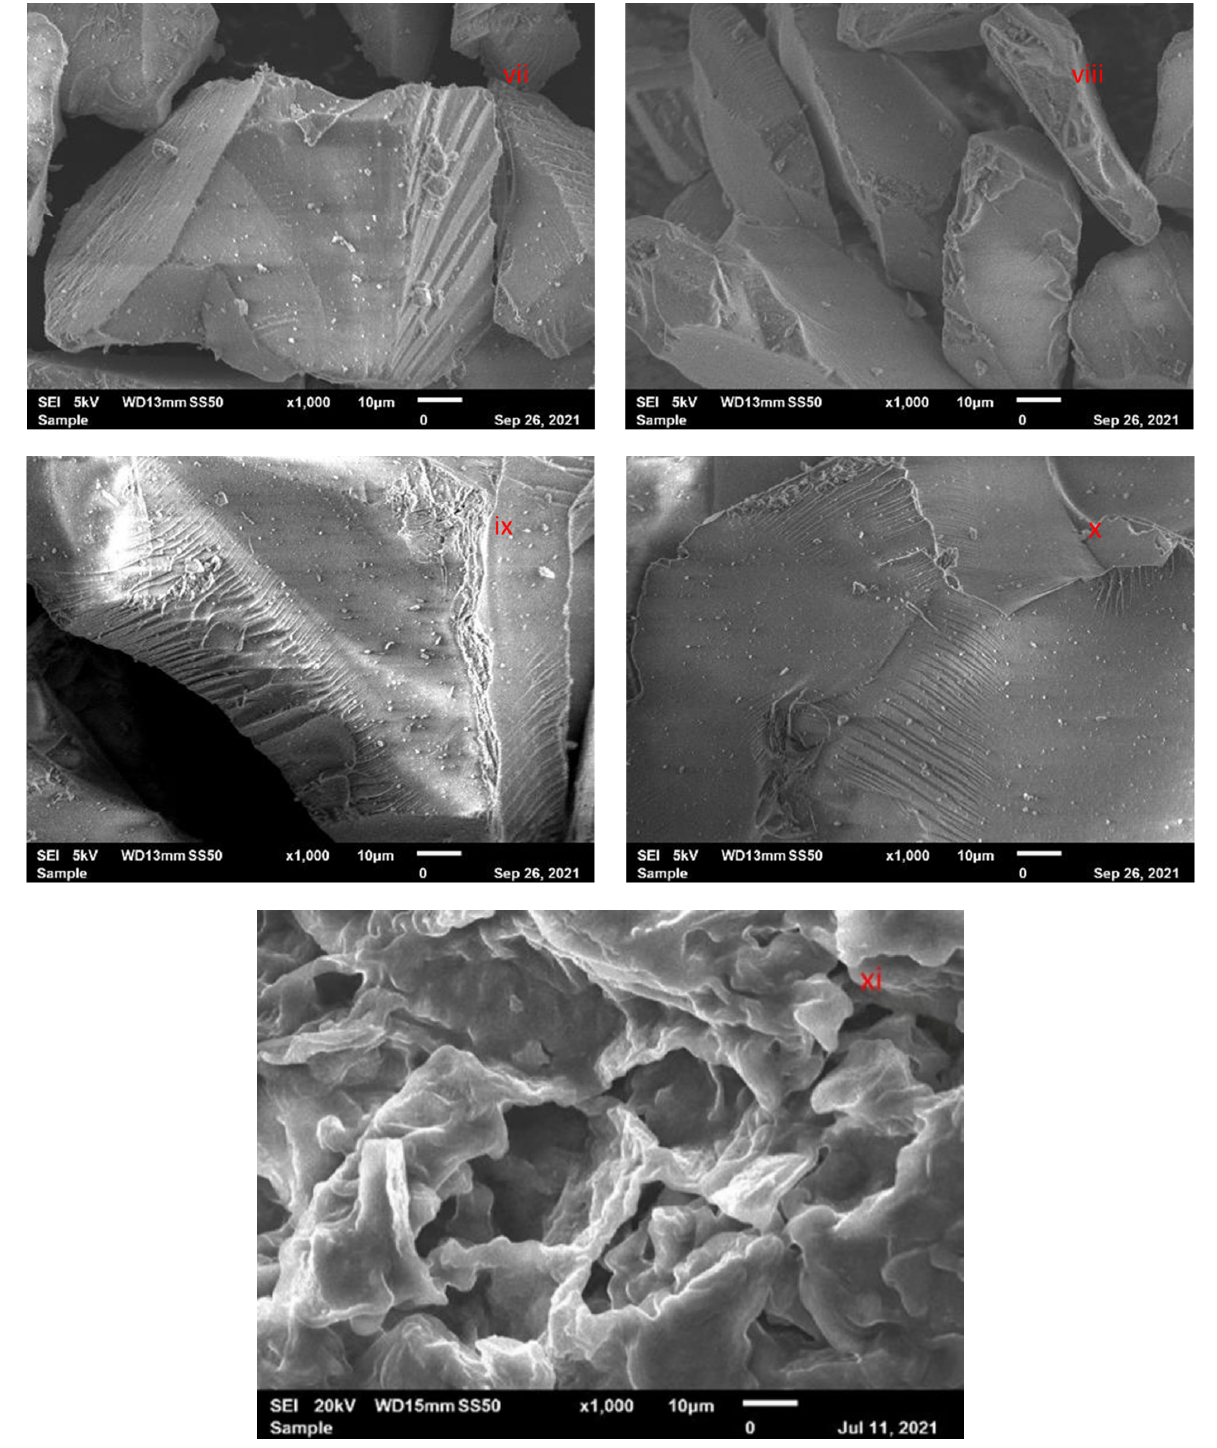
Figure 3. SEM images of ( i ) pure alginite (1000× magnification), ( ii ) one-time recycled alginite (1000× magnification), ( iii ) pure acidic alumina (1000× magnification), ( iv ) five-time recycled acidic alumina (1000× magnification), ( v ) pure basic alumina (1000× magnification), ( vi ) five-time recycled basic alumina (1000× magnification), ( vii ) used silica (1000× magnification), ( viii ) first-time recycled used silica (1000 × magnification), ( ix ) coarse silica (60–120 mesh) before adsorption (1000 × magnification), ( x ) coarse silica after the first recycling (1000 × magnification), and ( xi ) ACCG (1000 ×